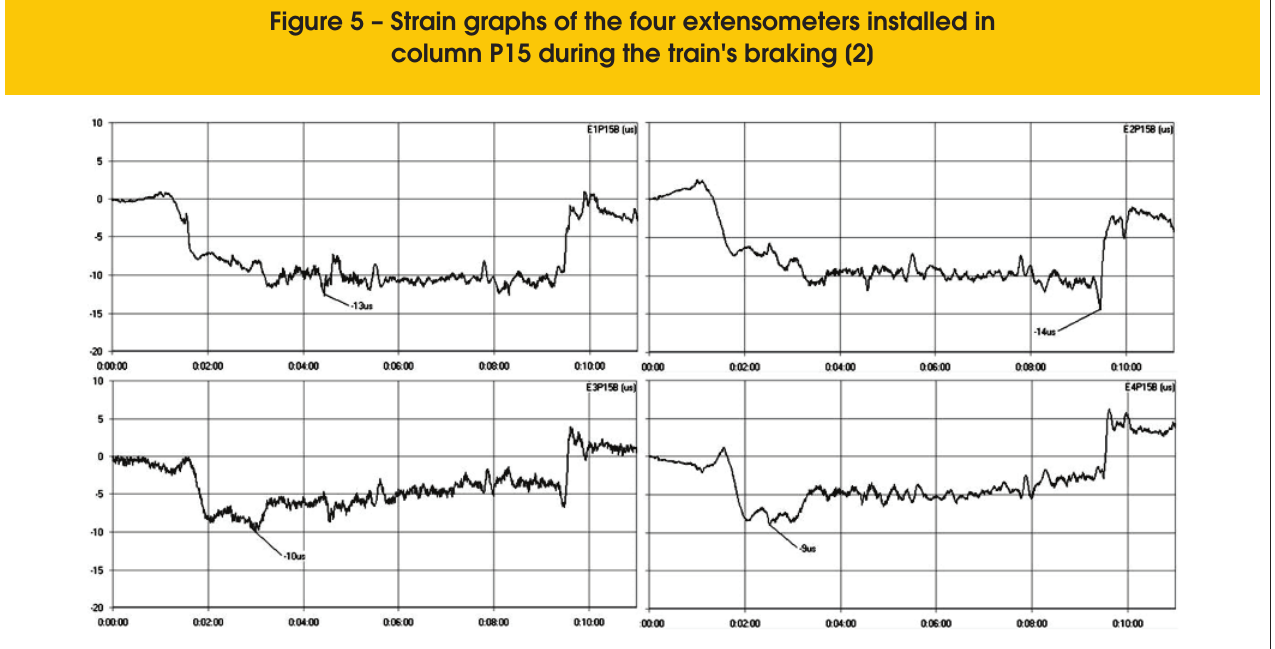
Figure 5 – Strain graphs of the four extensometers installed in column P15 during the train's braking